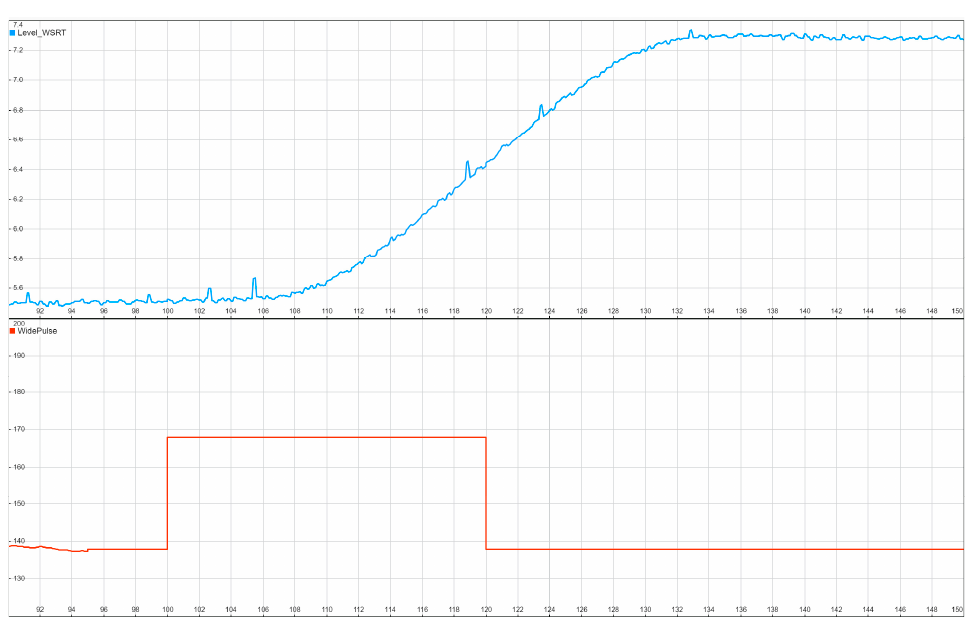
Figure 9. Wide step response of process (blue), wide step excitation (red): flow setpoint (magnitude of wide step excitation is u = 168 − 138 = 30 kg/s), duration of pulse excitation is 20 s, end of the experiment t end = 150